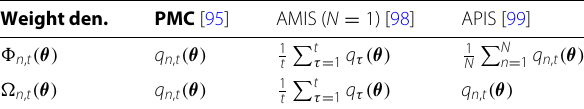
Table 3 Examples of (cid:21) n , t (function used in the denominator for the estimation) and (cid:22) n , t (function used in the denominator for the adaptation) that can be found in the literature Weight den.